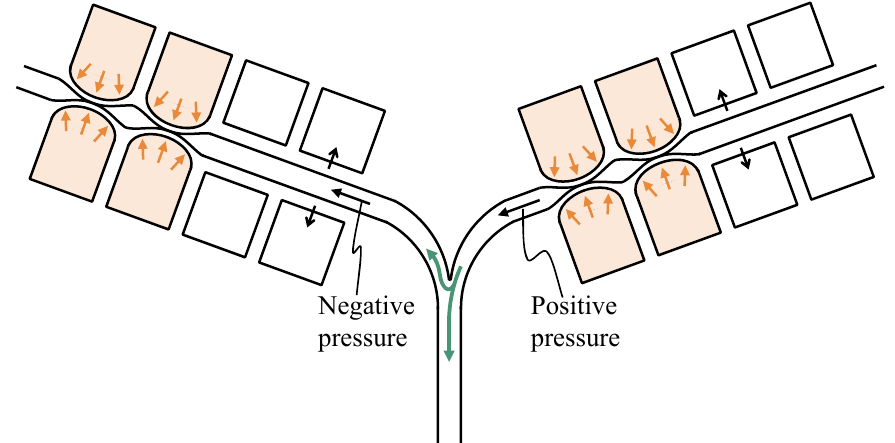
Figure 11. Mechanism for reducing backflow of the parallel pump.